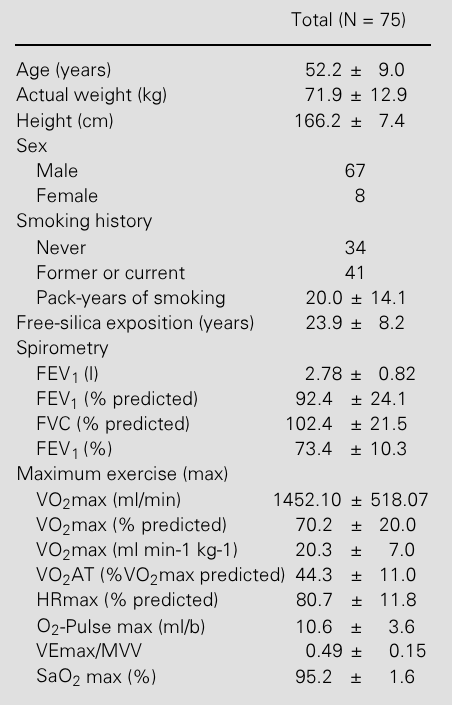
Table 2 - Subject characteristics, pulmonary func- tion and exercise performance. Results are reported as mean – SD for continuous variables and as absolute and % values, for the others. FVC: Forced vital capacity; FEV 1 : forced expiratory volume in one second of the FVC; VO 2 : oxygen consumption; VO 2 AT: oxygen consump- tion at the anaerobic threshold; HR: heart rate; VE: minute ventilation; MVV: maximal voluntary venti- lation; SaO 2 : saturation of